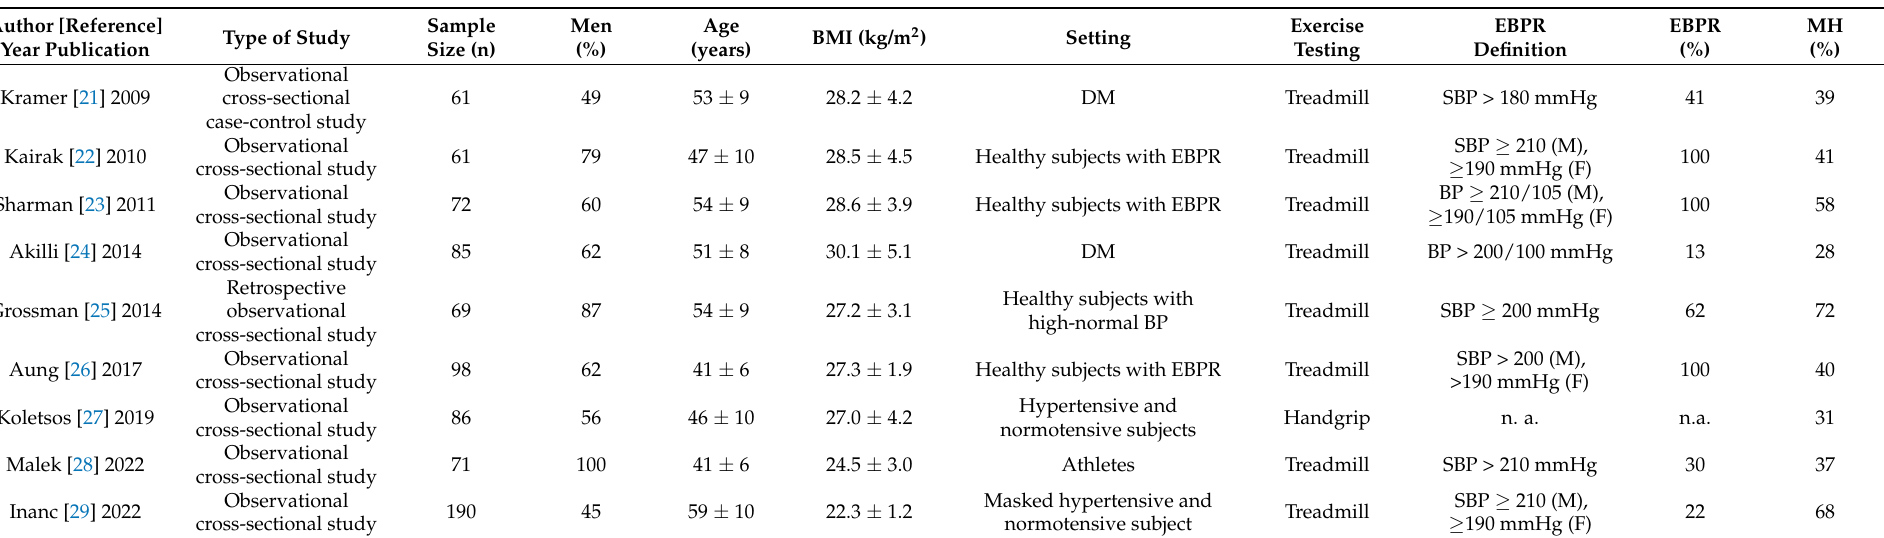
Table 1. Summary of nine studies that addressed the relationship between exaggerate blood pressure response to exercise and masked hypertension. Data are pre- sented as absolute numbers, percentage, mean ± SD. BMI = body mass index; EBPR = exaggerated blood pressure response to exercise; MH = masked hypertension.